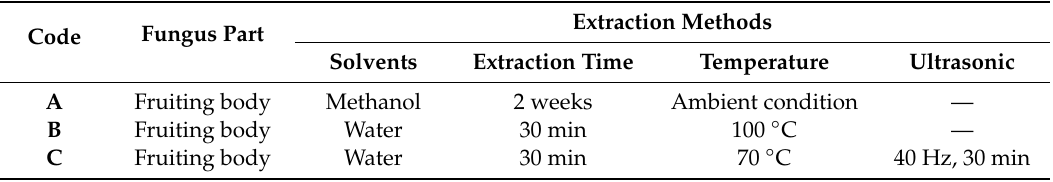
Table 6. Comparison of cordycepin content in di ff erent extractions.